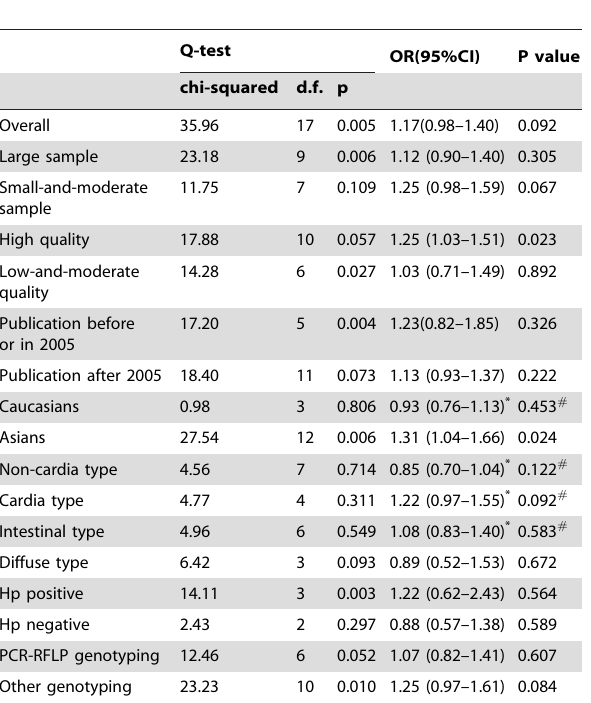
Table 3. Stratification for the test of heterogeneity on IL-8 - 251 AA vs TT based on a codominant